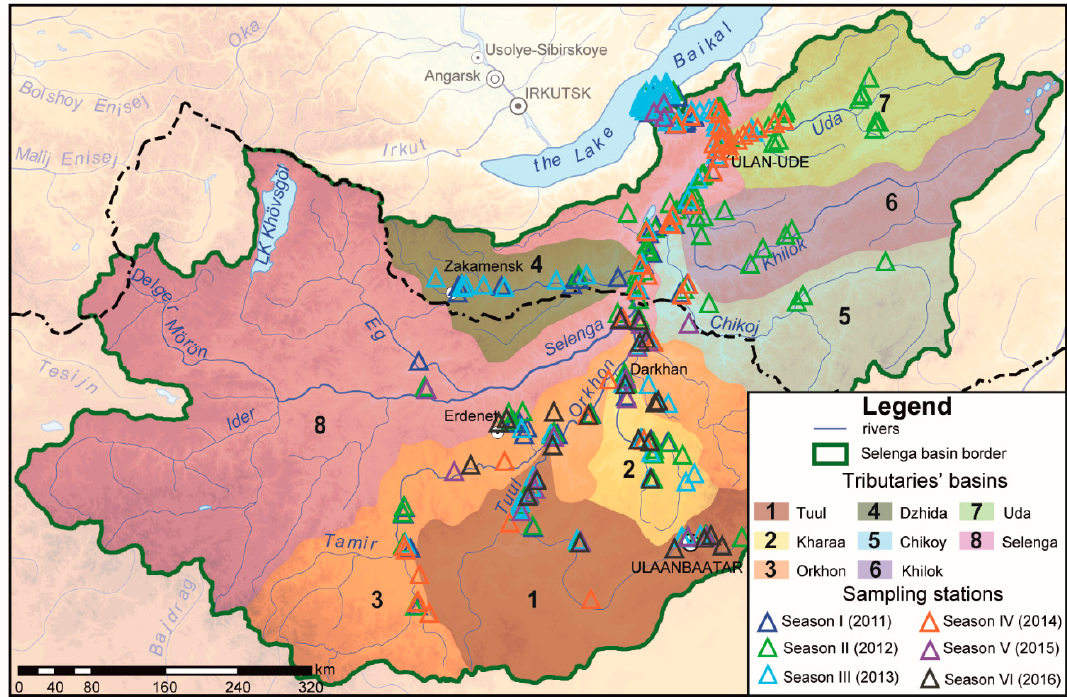
Figure 1. Selenga River and its tributaries catchments (numbered), as well as sampling stations for the field campaigns between 2011–2016 of this study.